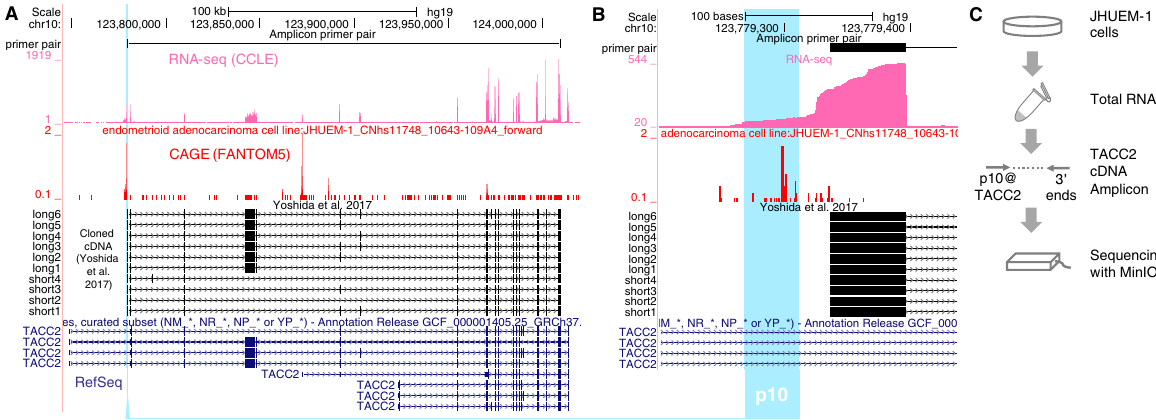
Figure 1. The intronic promoter p10 of the TACC2 gene is active in the endometrial cancer cell line JHUEM- 1. ( A ) Genomic view of the transcriptome (RNA-seq and CAGE) of the TACC2 locus with known isoforms. Turquoise background indicates the same region of p10, pink and red bars indicate signal intensities of RNA- seq and CAGE. Black and blue boxes indicate exons of gene models previously reported and included RefSeq database. ( B ) Close-up view of the intronic promoter region. ( C ) Schematic representation of our